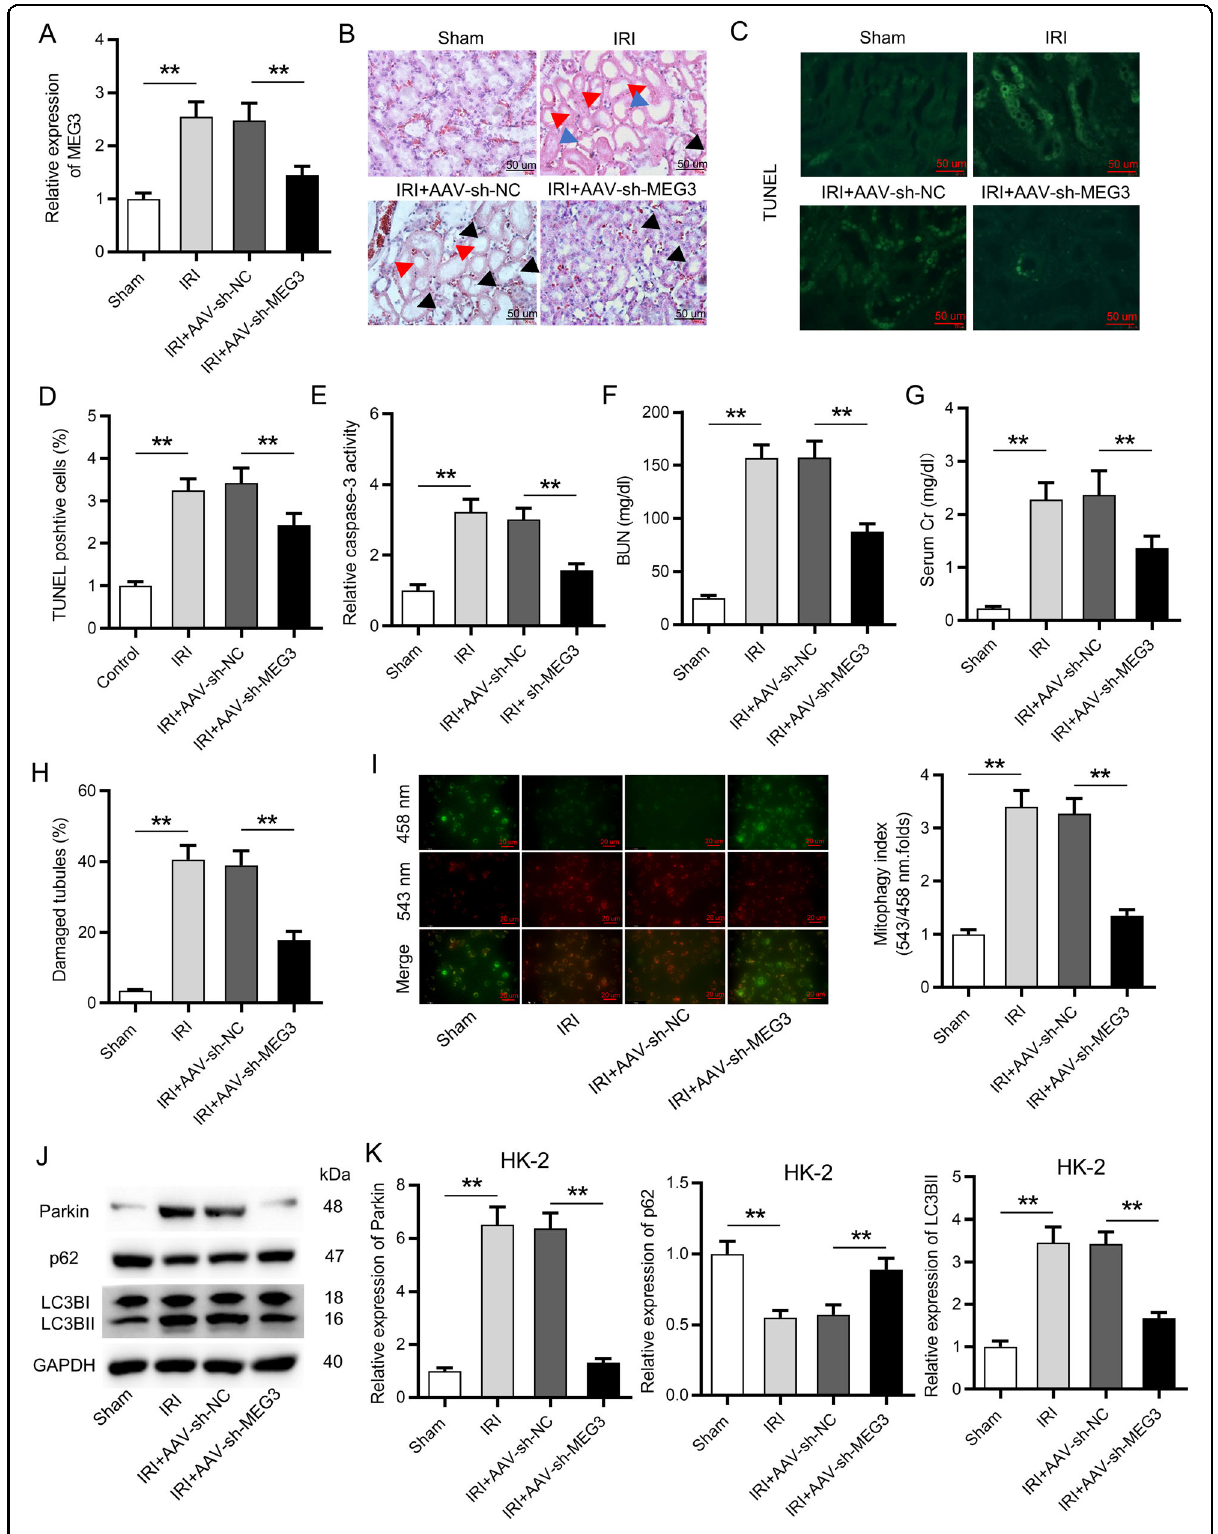
Fig. 3 (See legend on next